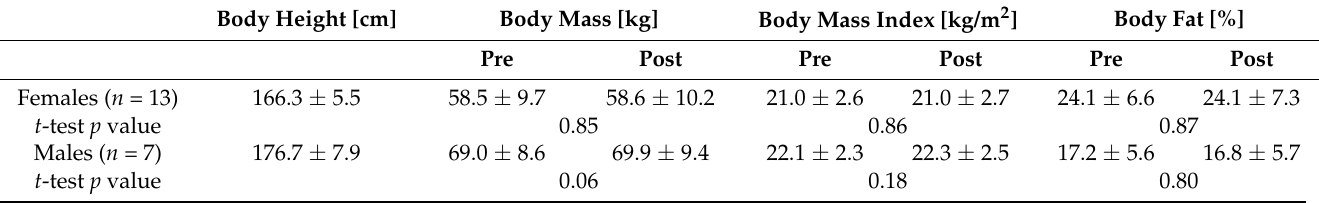
Table 1. Body composition in examined students in 14-week period of COVID-19 pandemic. Data is presented as mean value ± standard deviation.